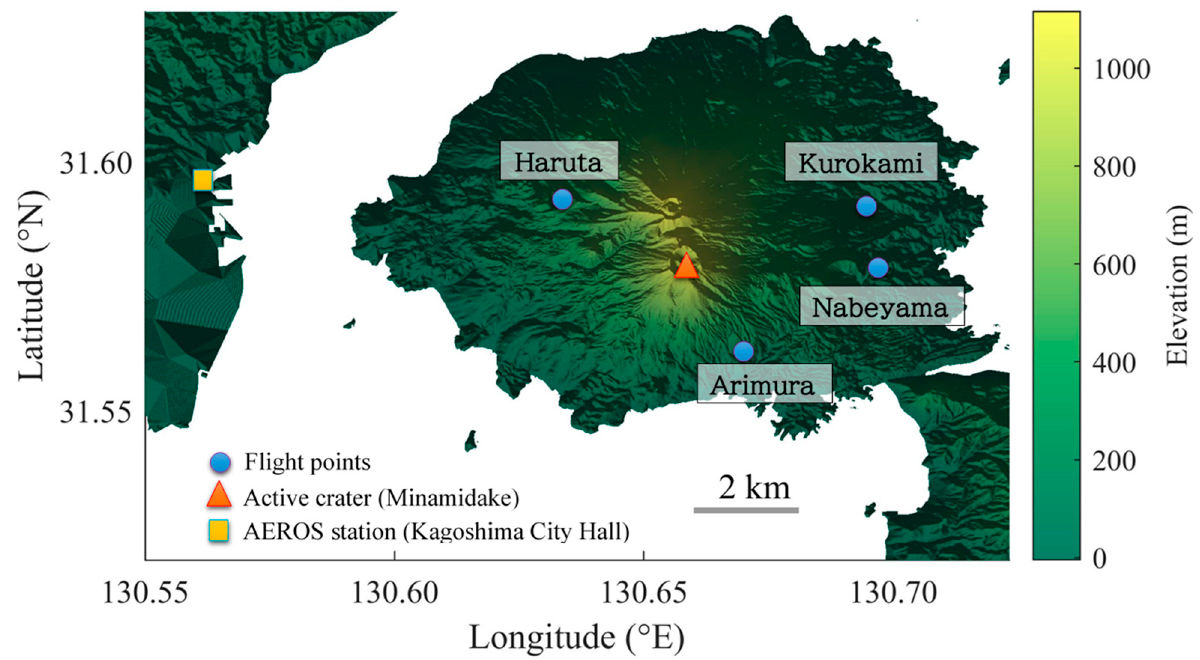
Figure 3. Volcanic observation sites at Sakurajima. The round blue markers indicate drone flight locations; the triangular marker indicates the active crater location, and the square maker indicates the Atmospheric Environmental Regional Observation System (AEROS) station. Elevation information was obtained from the Geospatial Information Authority of Japan (https://fgd.gsi.go.jp/download/menu.php, accessed on 23 March 2018).